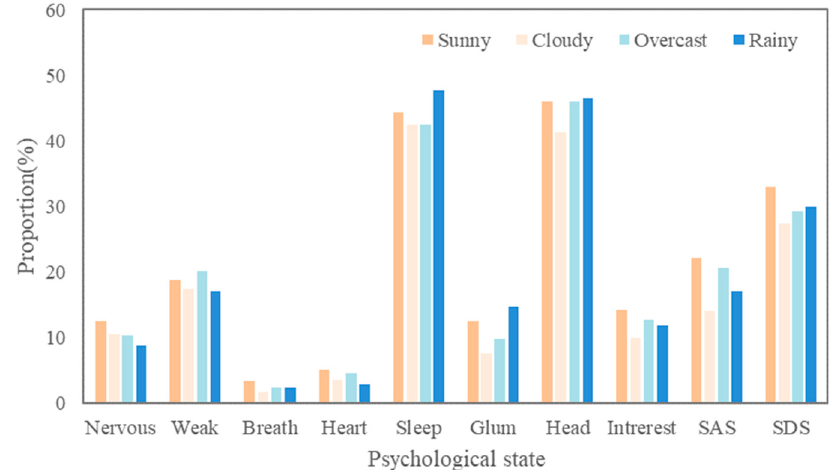
Figure 16. Weather differences in the psychological state.